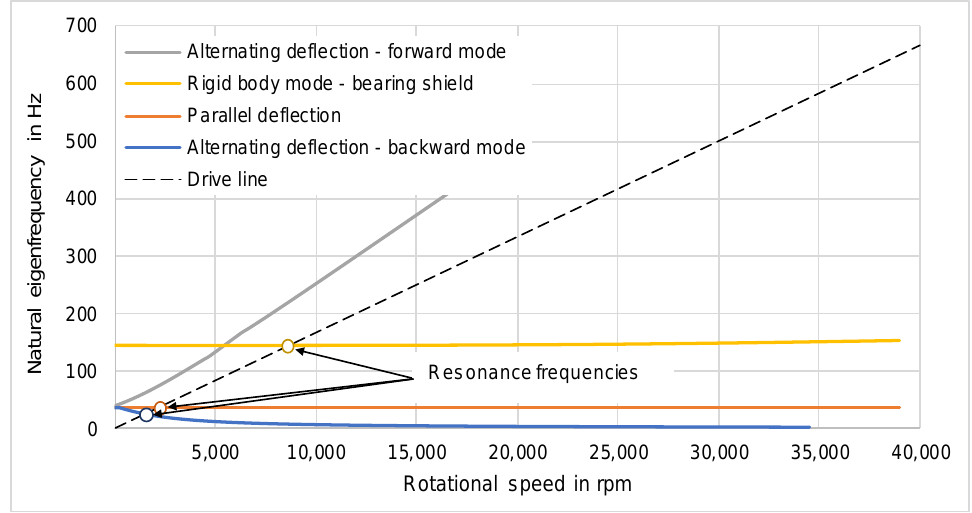
Figure 8. Campbell plot of the rotor-bearing system with a resilient suspension stiffness of 5 N/µm Simulation conducted with MESYS Shaft (Version 07-2019, MESYS AG, Zürich, Switzerland).